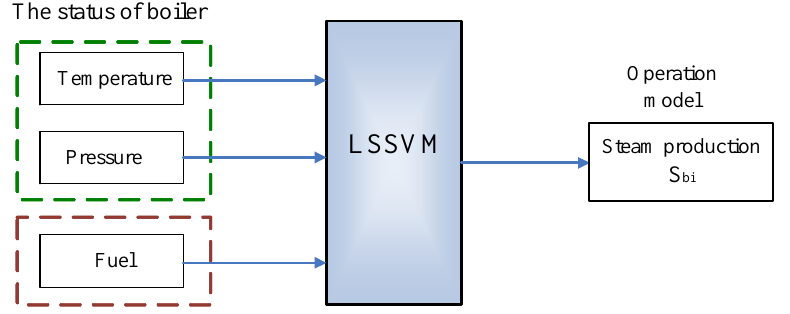
Figure 2. Operation model of boilers using the LSSVM.